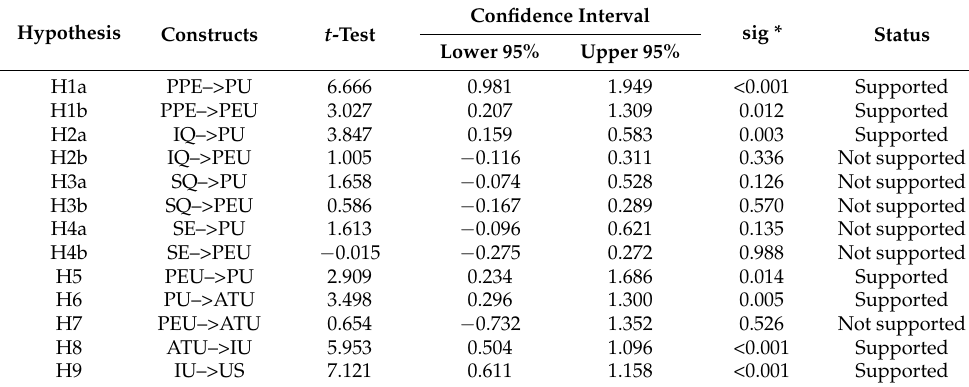
Table 3. Regression analysis result of the H5P